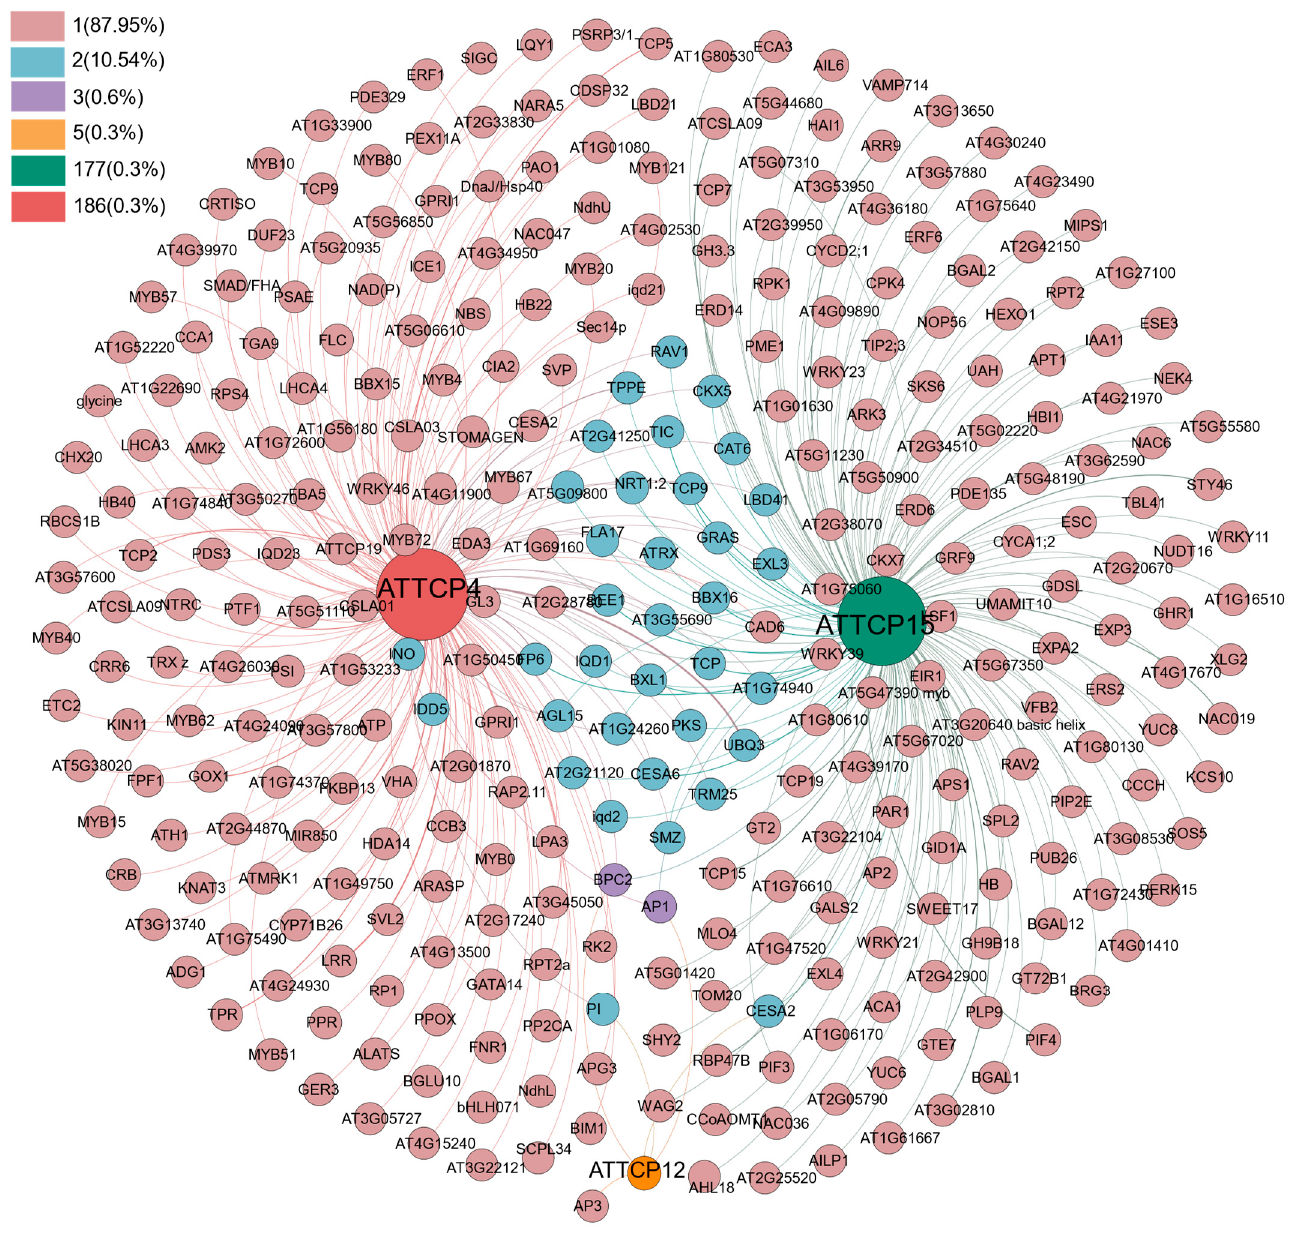
Figure 10. Gene regulatory network of AtTCP12 , AtTCP4 and AtTCP15 . Note: Different colors represent different degrees of connectivity, the percentages in parentheses indicate the percentage of that degree.